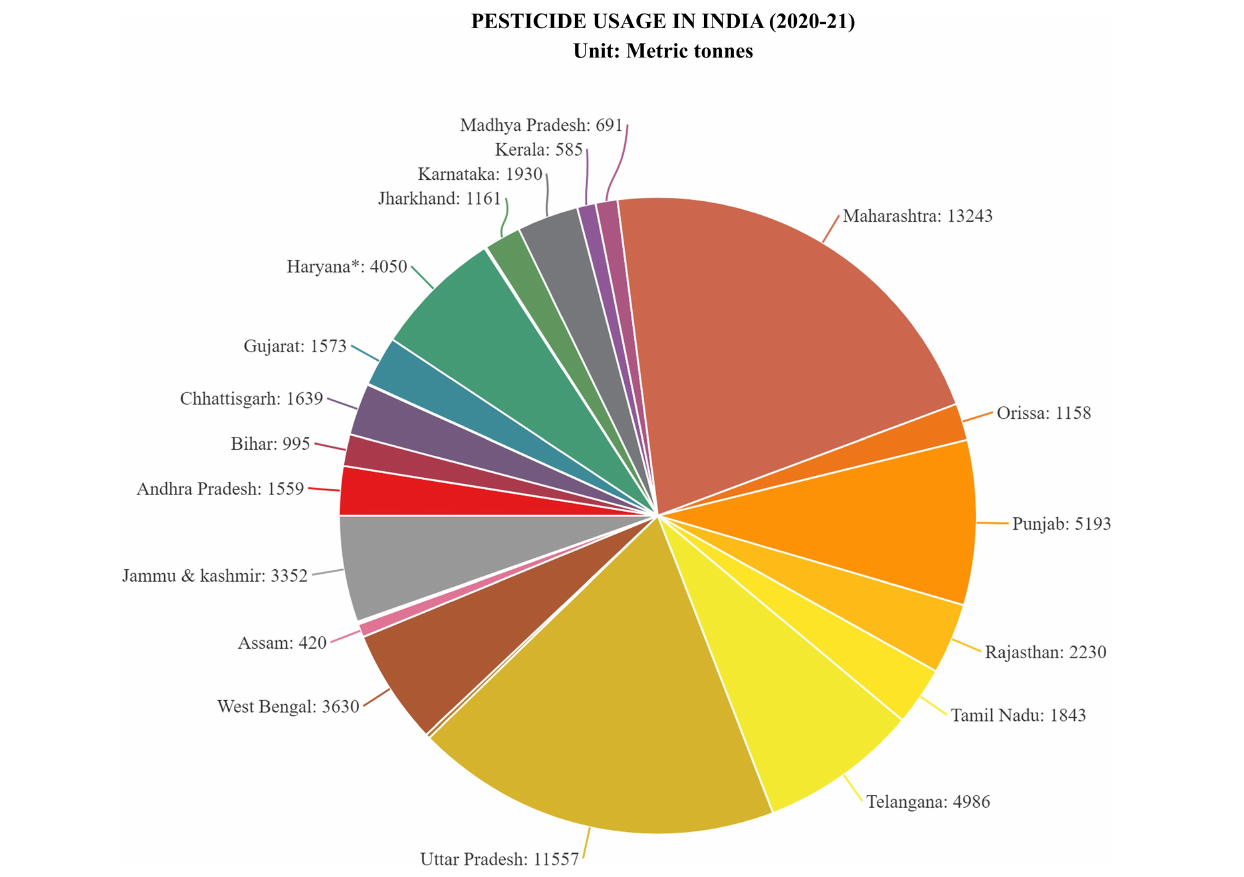
FIGURE 2 | Pesticide use in India (2020–21), [Unit: Metric tons (M.T)]. Pie-chart representing the average usage of pesticide by different Indian states in the year 2020–21. Highest usage among the states for which the pie-chart is made has been noted for Maharashtra with average usage of 13,243 M.T. while lowest for Andaman and Nicobar island with 1 M.T. Data were taken from statistical database of government of India, directorate of plant protection, quarantine and storage ( Statistical Database | Directorate of Plant Protection, Quarantine and Storage | GOI, 2021).